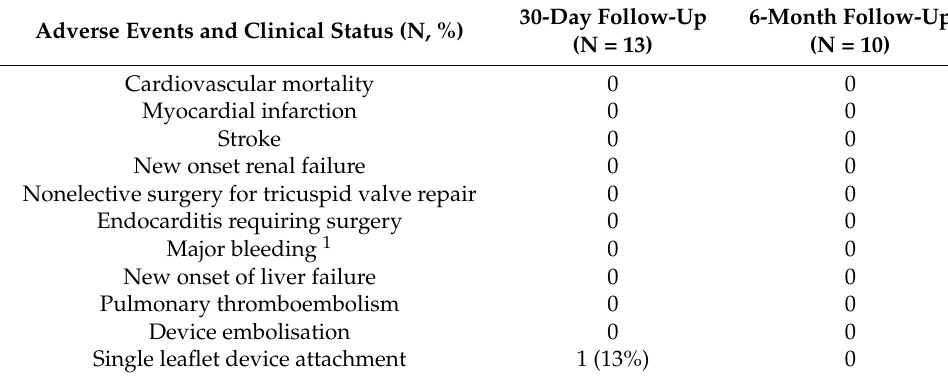
Table 3. Adverse events and clinical safety endpoints at